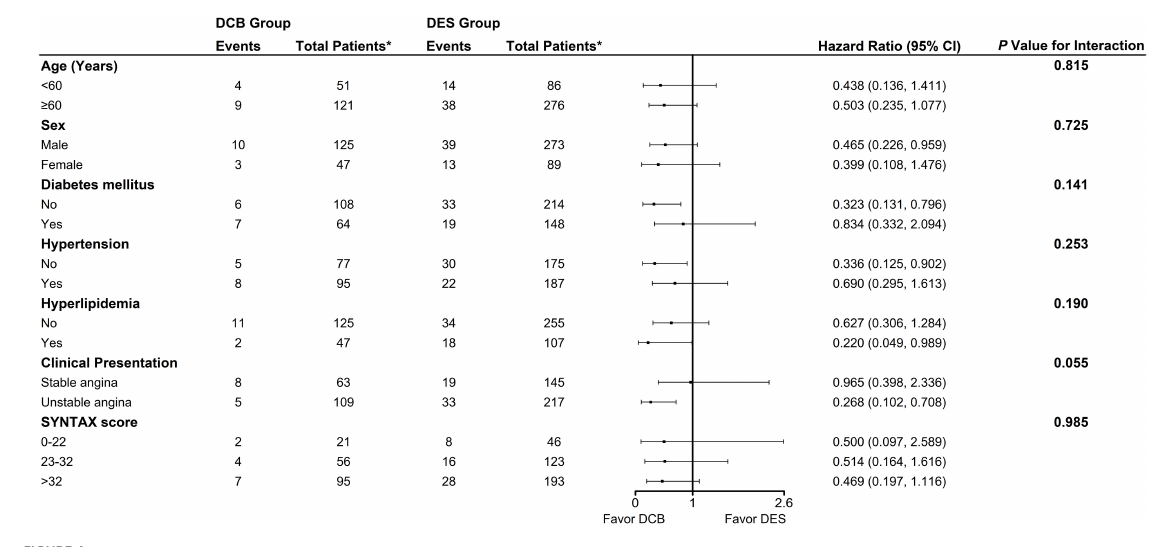
FIGURE4 Subgroup analysis: Risk of primary outcome among propensity-score matched cohort. “*Total patients” means numbers of patients at follow up. DCB, drug-coated balloon; DES, drug-eluting stent; SYNTAX, synergy between percutaneous coronary intervention with taxus and cardiac surgery.